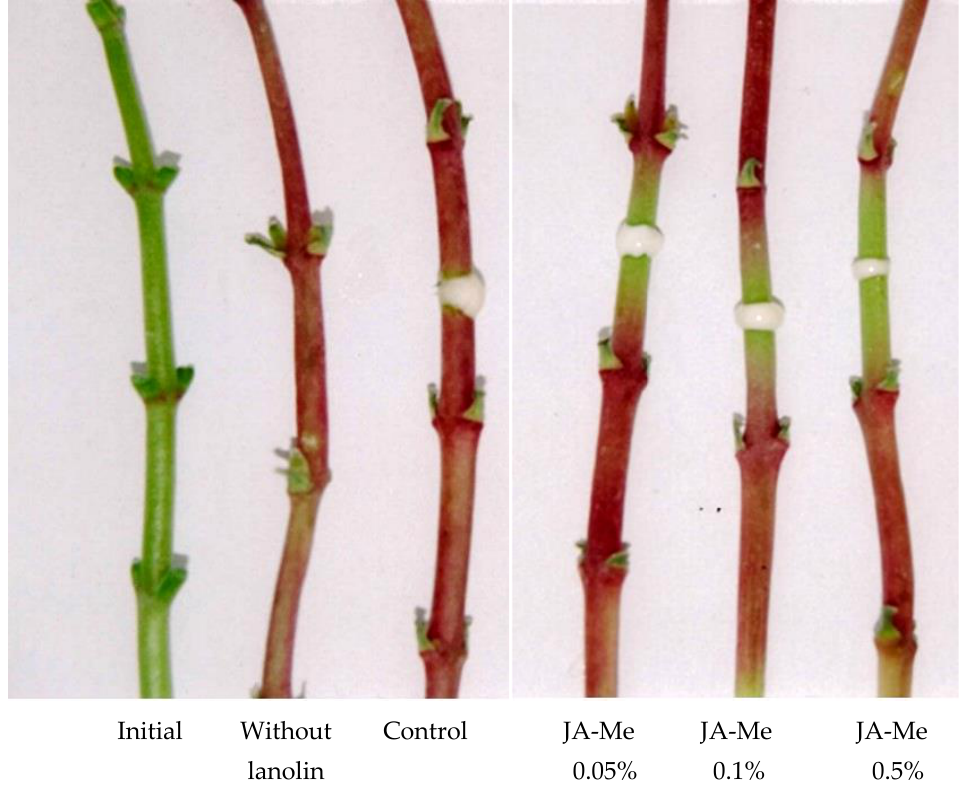
Figure 6. Effect of JA-Me in lanolin on anthocyanin accumulation in excised stems of K. blossfeldiana . JA-Me was applied as a lanolin paste, then the treated stem segments were kept in natural light conditions. Pictures were taken 4 days after treatment.